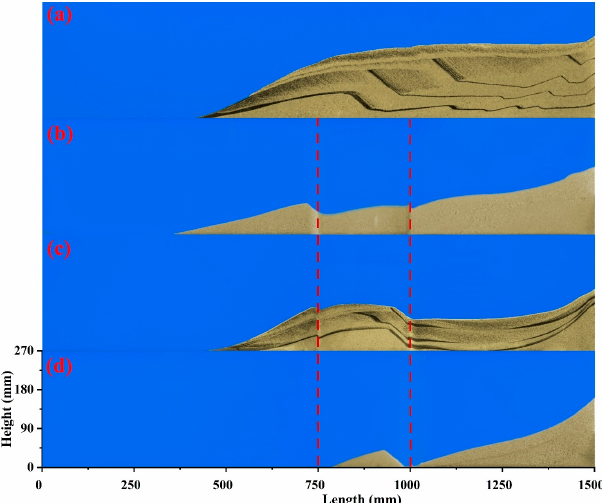
Figure 15. Snapshots of 70/140 mesh sand dunes in four channels at the stable status at Re = 3311 and L 1 /L = 0.5, front view: ( a ) The straight channel, θ = 180°; ( b ) The curving channel, θ = 135°; ( c ) The curving channel, θ = 90°; ( d ) The curving channel, θ = 45°. ( c ) The curving channel, θ = 90 ◦ ; ( d ) The curving channel, θ = 45 ◦ .